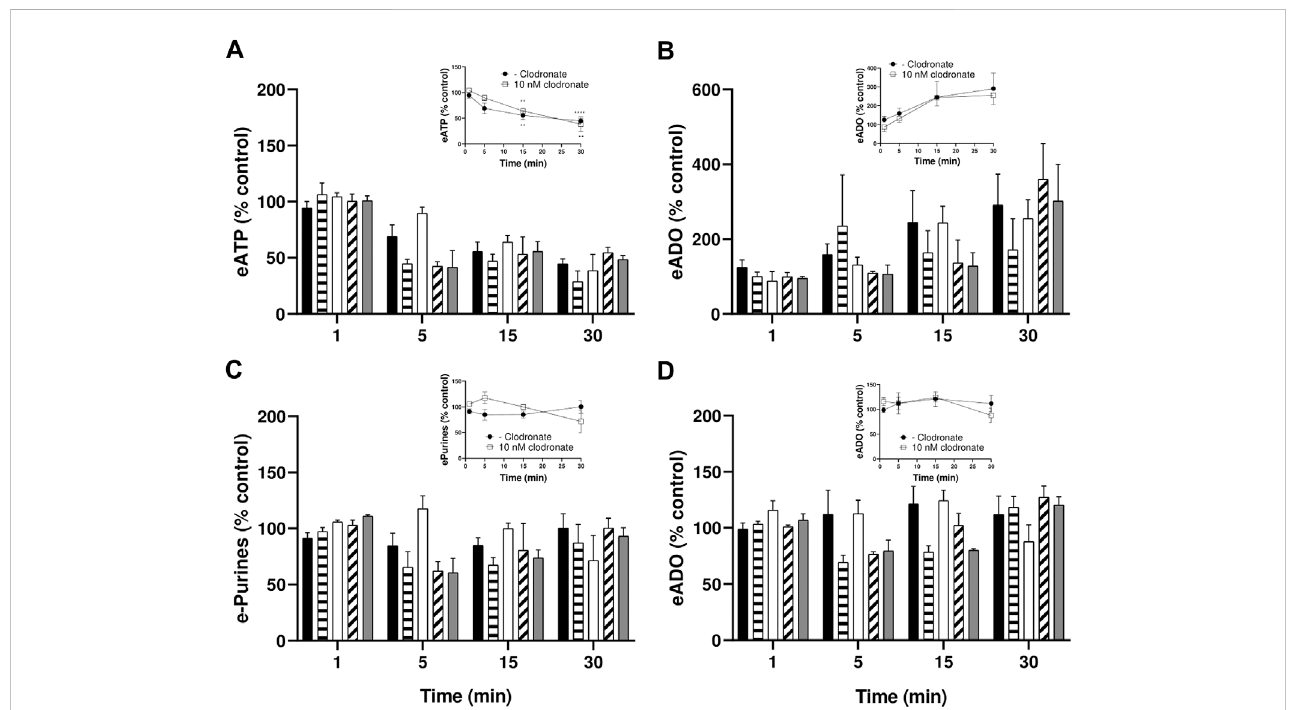
FIGURE 4 Endothelial cells metabolize eATP but not eADO, lack of inhibition by 1 – 1,000 nM clodronate. To ascertain whether clodronate interferes with ectoATPase cell metabolism, cultures of mesentery cells were incubated with eATP, and its metabolism was followed over 30 min. (A) Decay of 50 mM eATP added to the extracellular media. (B) shows the corresponding eADO accumulation in cells treated with eATP, while (C) depicts the total etheno purines from the same cells depicted, evidencing that the extracellular etheno purines were maintained over time. In contrast, (D) shows the application of 25 nM eADO to a separate, but parallel, set of endothelial mesentery cells. Closed columns represent controls in the absence of clodronate ( n = 8), dashed columns depict 1 nM clodronate ( n = 4), open columns 10 nM clodronate ( n = 6), oblique dashed columns 100 nM clodronate ( n = 4), and gray columns 1,000 nM clodronate( n =4).Barsinthecolumnsshow theS.E.M. Nosigni fi cantdifferencewasobserved whencomparingcontrolsversustheclodronate effectateach incubation time.Insetsofthese Figuresshow theeffect of10 nMclodronate (opensquares, n =6)comparedto aparallelsetofcellsincubated intheabsence of the bisphosphonate (closed circles, controls, n = 8). Symbols indicate the mean S.E.M. **, p < .01, and ****, p < .0001 unpaired t-test compared to the corresponding 1-min controls.